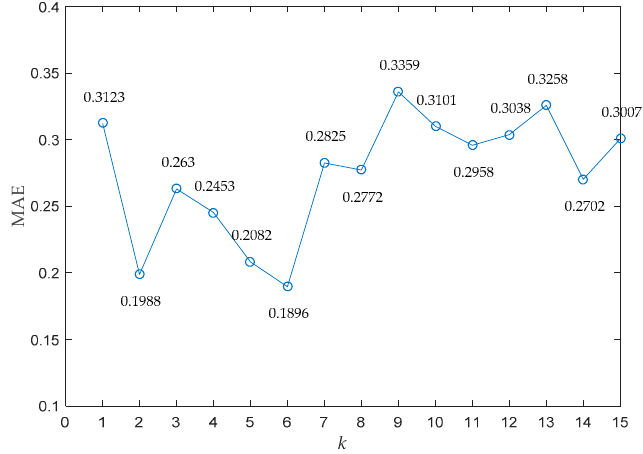
Figure 4. MAE of the training dataset with different parameter k .